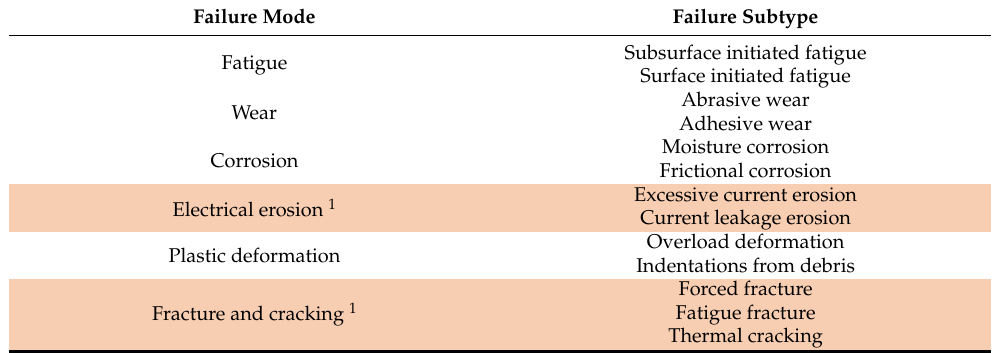
Table 1. Damage and failures in rolling bearings according to ISO 15243